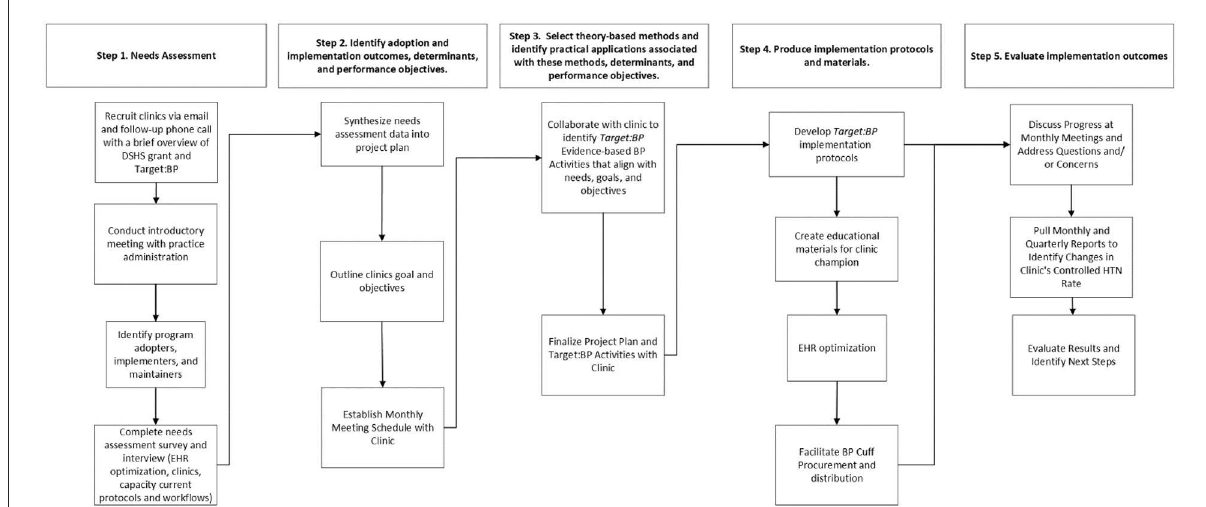
FIGURE1 This workflow was created using the implementation mapping steps from Bartholomew Eldredge et al. (17). The adoption and implementation performance objectives examples influencing the adoption and implementation of the Target:BP TM shown in this table came from the